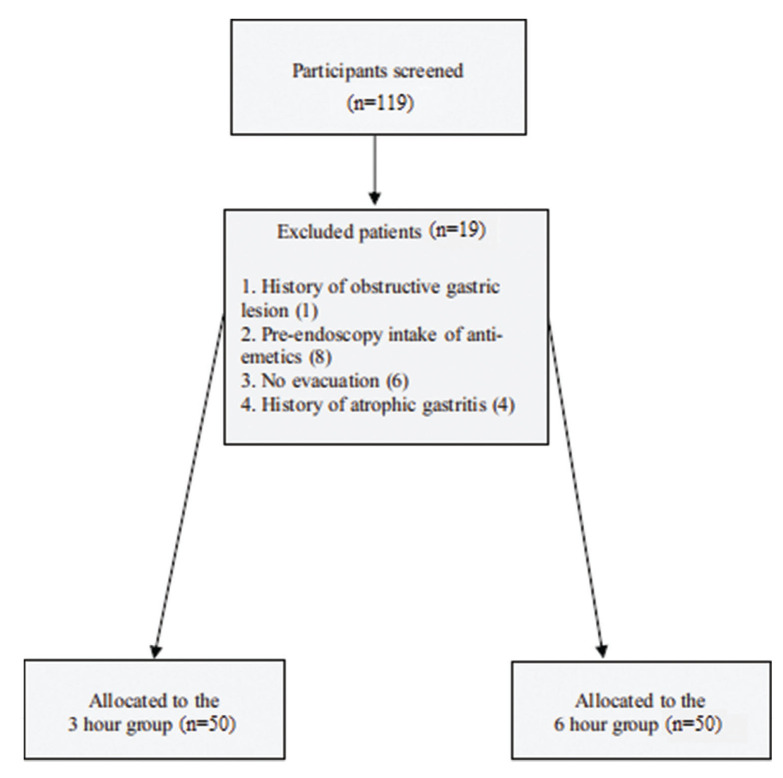
Study flowchart.